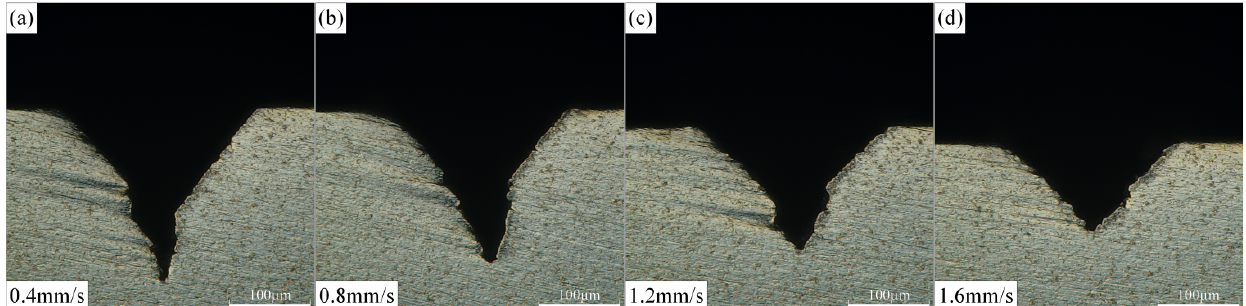
Figure 8. Effect of cutting speed on microgroove morphology. ( a ) Cutting speed is 0.4 mm/s, ( b ) Cutting speed is 0.8 mm/s, ( c ) Cutting speed is 1.2 mm/s, ( d ) Cutting speed is 1.6 mm/s.